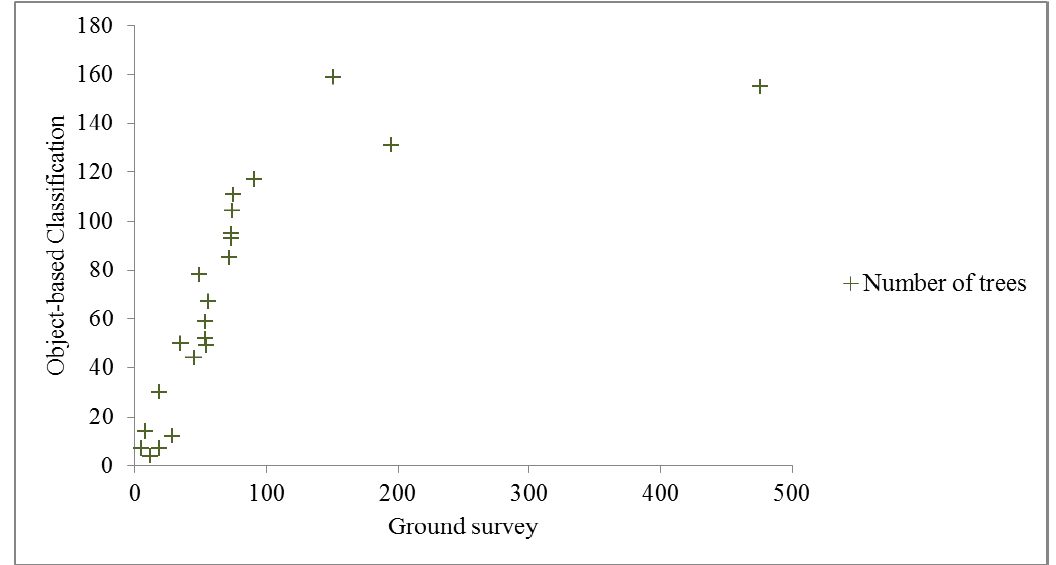
Figure 6. Correlation between number of trees assessed in the ground survey of 21 grids and the number of trees calculated from object-based